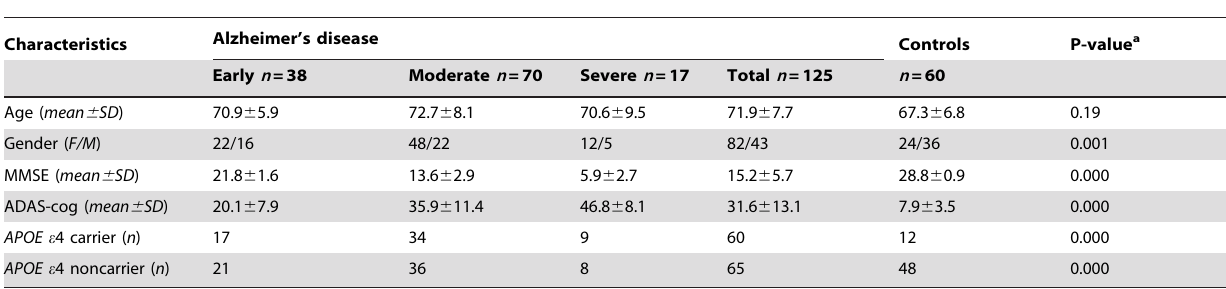
Table 1. Demographic and clinical